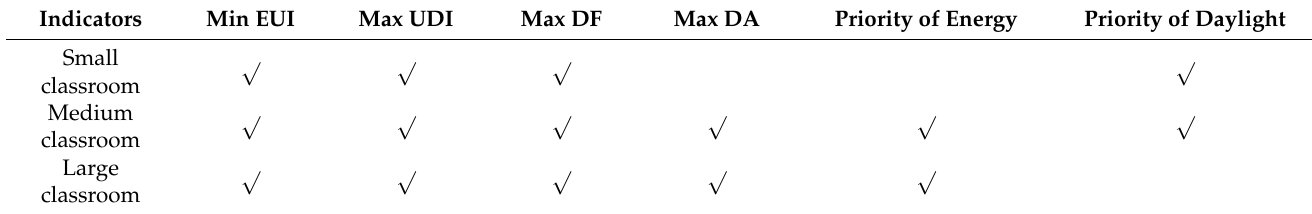
Table 5. Selection of test indicators for different types of classrooms.